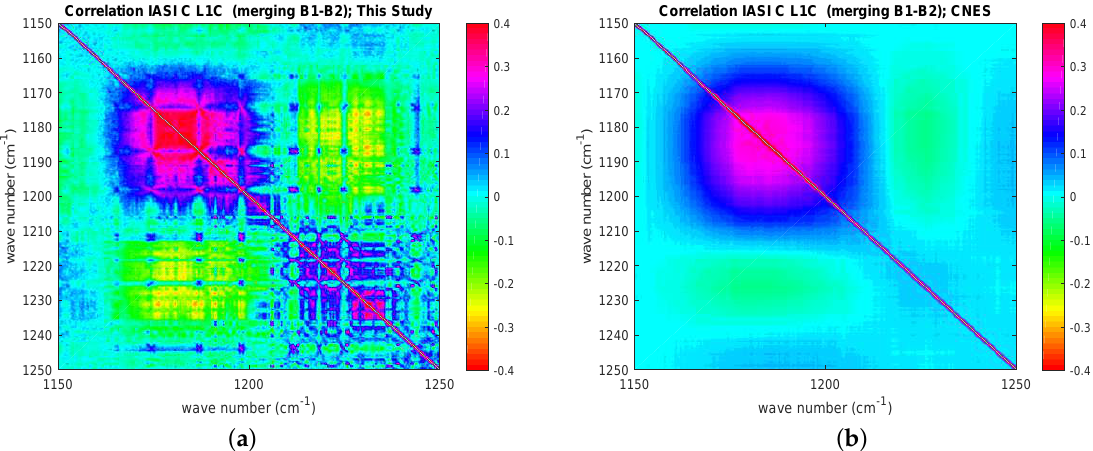
Figure 9. ( a ) IASI-C S ε transformed to correlation matrix estimated on the basis of Earth-scene views. The figure zooms in the spectral range corresponding to the merging of IASI bands 1 and 2. ( b ) The same as in ( a ), but now the CNES release is shown for comparison. The diagonal has been subtracted to allow for a better visual inspection for possible correlation patterns. Results have been averaged over the four IASI